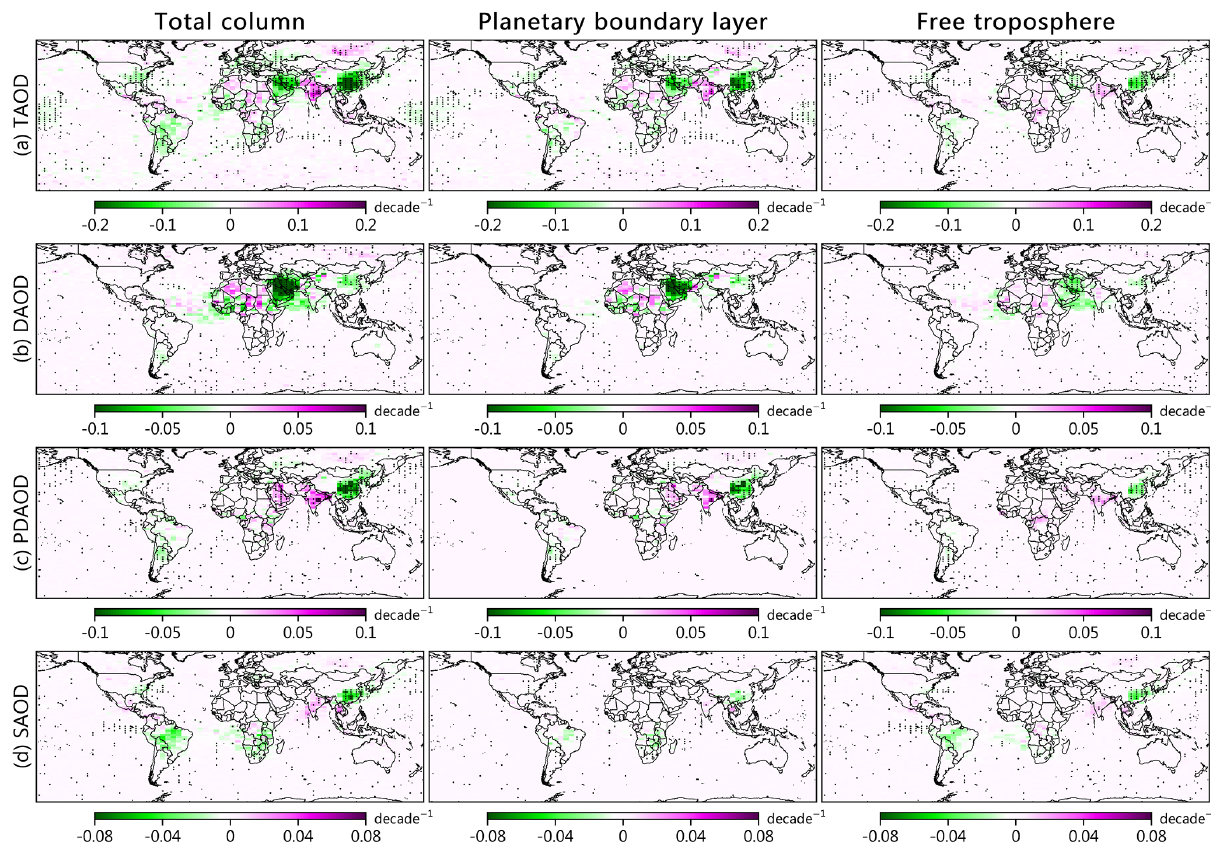
Figure 13. Spatial distributions of annual trends (unit: decade − 1 ) in (a) TAOD, (b) DAOD, (c) PDAOD, and (d) SAOD in the total column (left-hand-side panels), PBL (middle panels), and FT (right-hand-side panels), during the period 2007–2019. The grid points with trend values that are statistically significant at the 95% confidence level are marked with black ×